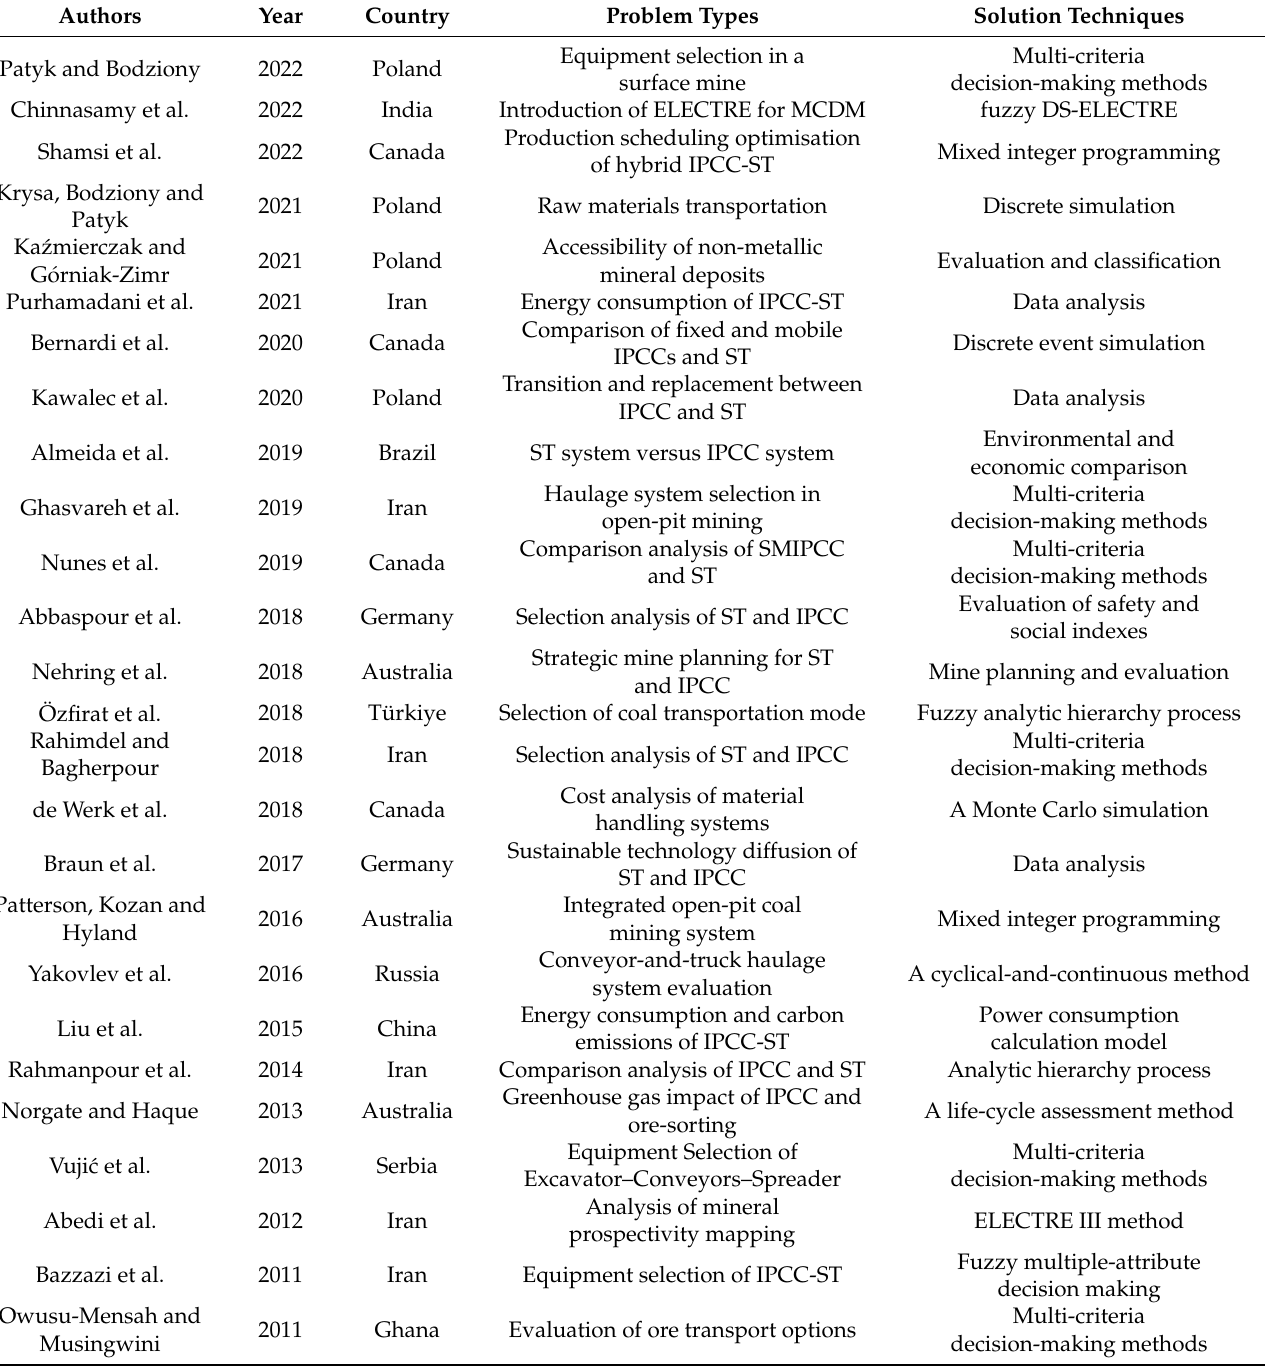
Table 3. Characteristics analysis of publications on the hybrid IPCC-ST system